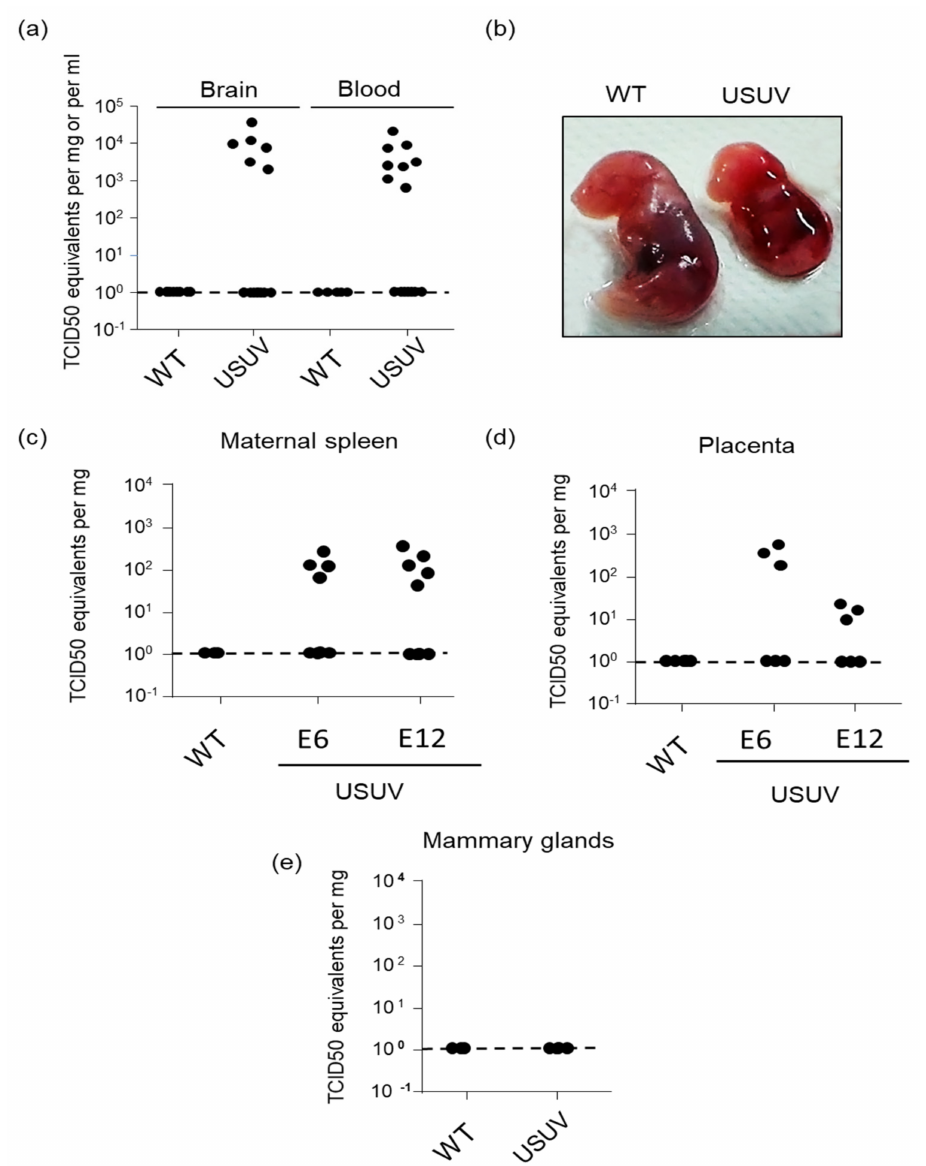
Figure 5. USUV can achieve congenital infection of immunocompetent mice and causes occasional fetal demise. C57BL/6 pregnant mice were inoculated with USUV by subcutaneous (footpad) route with 104 TCID50 in 50 µ L of PBS. ( a ) Brain and blood of suckling mice were collected after the birth for the brain and 2 weeks later for blood. Viral burden was measured by RT-qPCR assay and indicated by TCID50 equivalent per g or per ml. ( b ) Fetal demise in USUV-infected mice after cesarean section